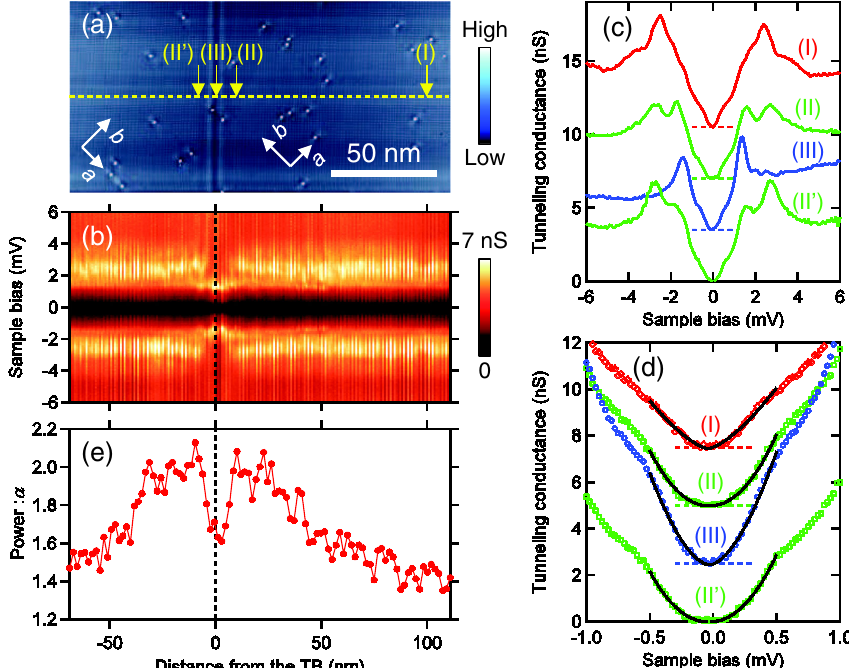
95 mV and I 100 pA. (b) Intensity plot of g ð r ; E Þ FIG. 2. (a) A constant-current STM image at 1.5 K near a TB taken at V s ¼ þ t ¼ 20 mV, I 100 pA, and V 0 . 05 mV along the yellow broken line in (a). V . Spectroscopic measurements are done at s ¼ þ t ¼ mod ¼ rms 0.4 K. (c) Tunneling spectra at the representative points indicated in (a). Positions (II) and (II 0 ) are symmetric about the TB. 20 mV, I 100 pA, and V 0 . 05 mV V . (d) High-resolution tunneling spectra at low E taken at the same positions as s ¼ þ t ¼ mod ¼ rms